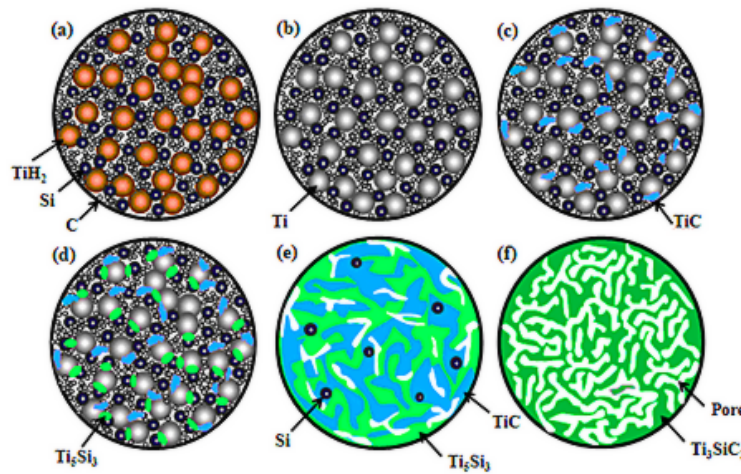
Figure 6. The schematic diagram of the reaction and pore evolution procedure in the sintering process. ( a ) A green compact is composed of TiH 2 , Si and C; ( b ) TiH 2 decomposed into Ti; ( c ) TiC began to generate; ( d ) Ti 5 Si 3 began to generate; ( e ) Intermediate phases of TiC and Ti 5 Si 3 were completely produced; ( f ) Porous Ti 3 SiC 2 were fabricated.